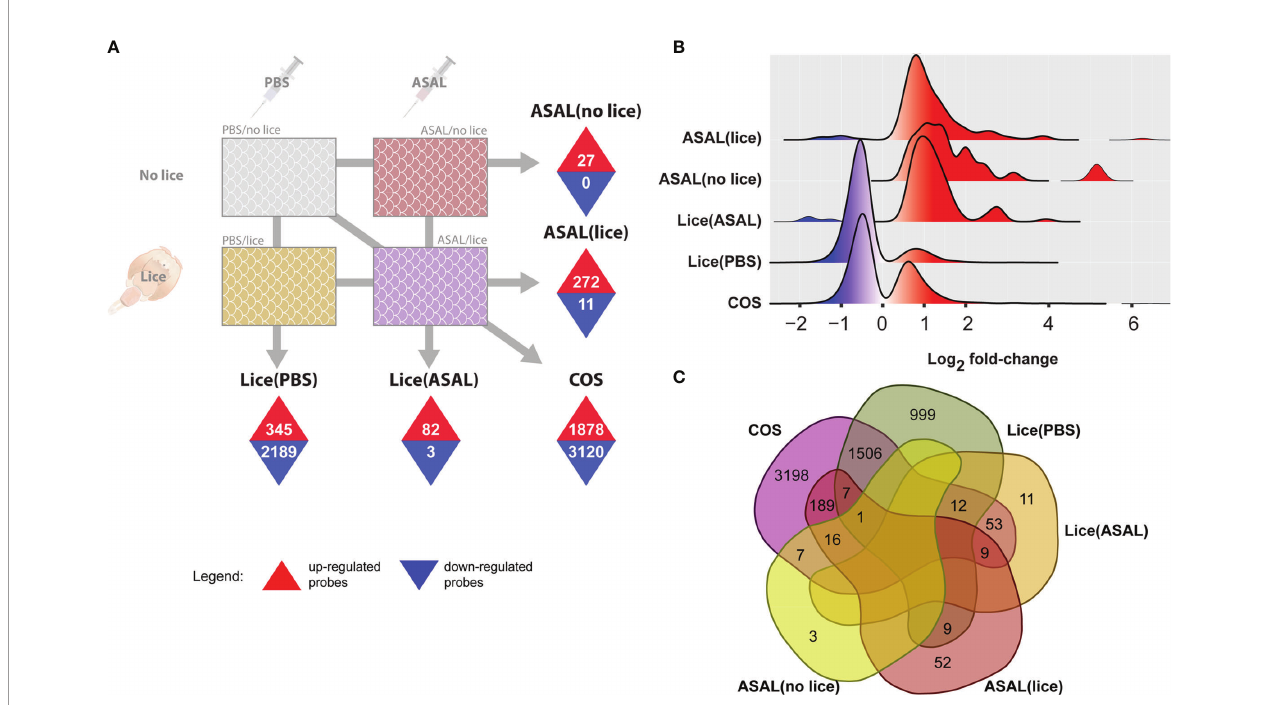
FIGURE 2 | Summary of microarray results. (A) Identi fi ed differentially expressed probes (DEPs) using SAM (5% FDR). Numbers inside upward pointing triangles represent the number of up-regulated DEPs; those inside downward pointing triangles represent the number of down-regulated DEPs. (B) Histogram of the frequency density of log 2 -transformed fold-changes for the different DEPs lists. Tones of red and blue colors indicate up- and down-regulation, respectively. (C) Venn diagram showing the total number of exclusive and overlapped DEPs among